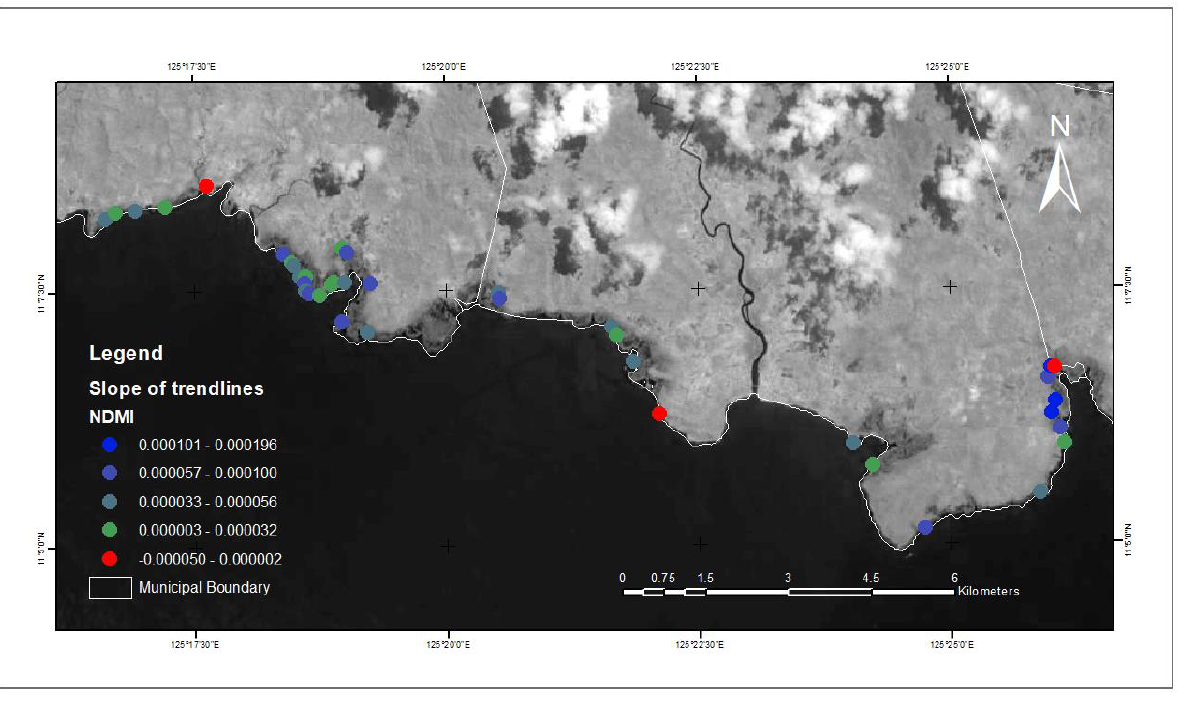
Figure 5: Estimated relative rates of mangrove “recovery” across the study area based on the slope of NDVI trend lines